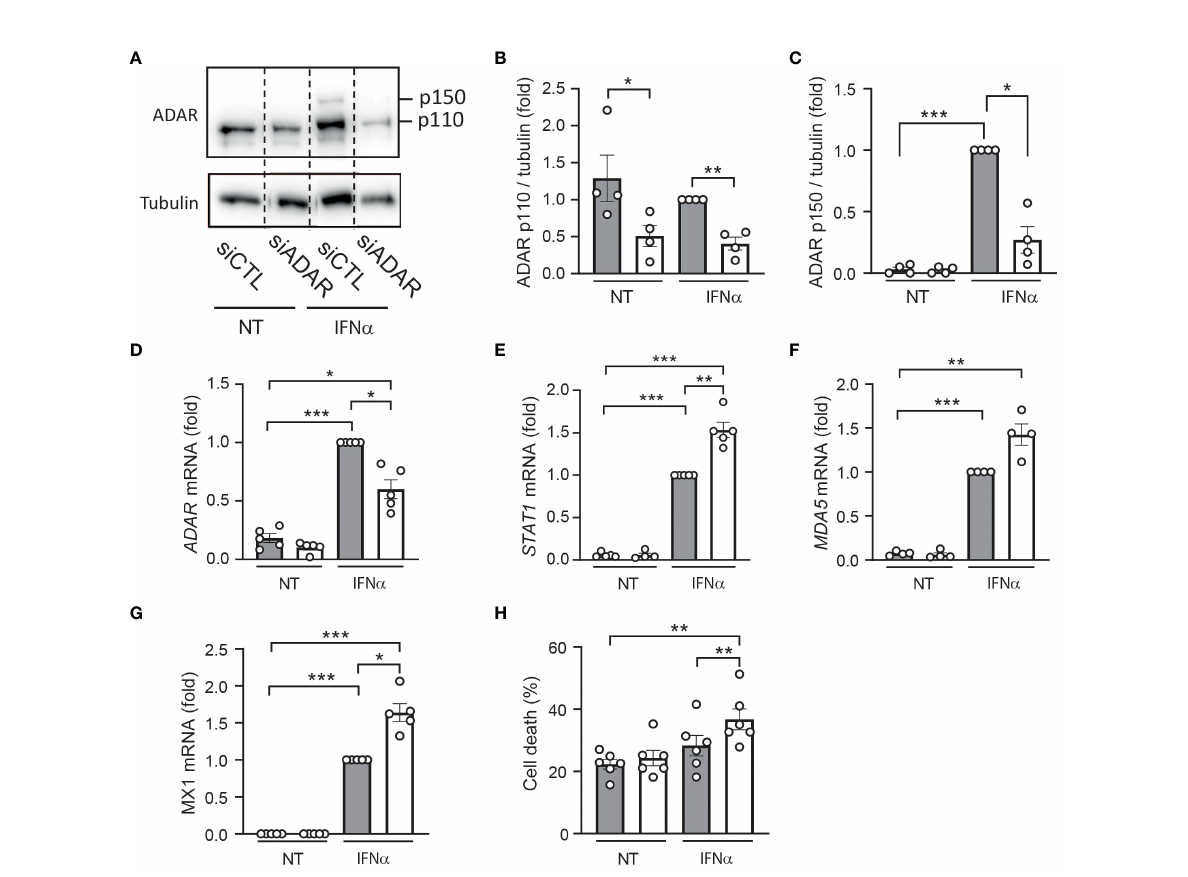
FIGURE 4 ADAR1 silencing exacerbates the effects of IFN a in human b cells. EndoC- b H1 cells were transfected with an siRNA control (siCTL: grey bars) or with an siRNA targeting ADAR (white bars) and left to recover for 48h. After this period, cells were left untreated (NT) or were treated with IFN a (2000 U/ml) for 24h. (A) Protein expression was measured by western blotting using Anti-ADAR1 antibody #14175 (Cell Signaling Technology) and representative images of 4 independent experiments are shown. Densitometry results are shown for ADAR p110 (B) and ADAR p150 (C) . mRNA expression of ADAR (D) , STAT1 (E) , MDA5 (F) and MX1 (G) was analyzed by RT-qPCR and normalized by b -actin. Values of siCTL + IFN a were considered as 1. (H) Cell death was evaluated using HO/PI staining. Data are expressed as means of independent experiments (shown as individual data points, n=4-6) ± SEM. Differences between groups were evaluated using one-way ANOVA or linear mixed model in case of missing values, followed by Bonferroni post-hoc test. * p <0.05, ** p <0.01 and **** p